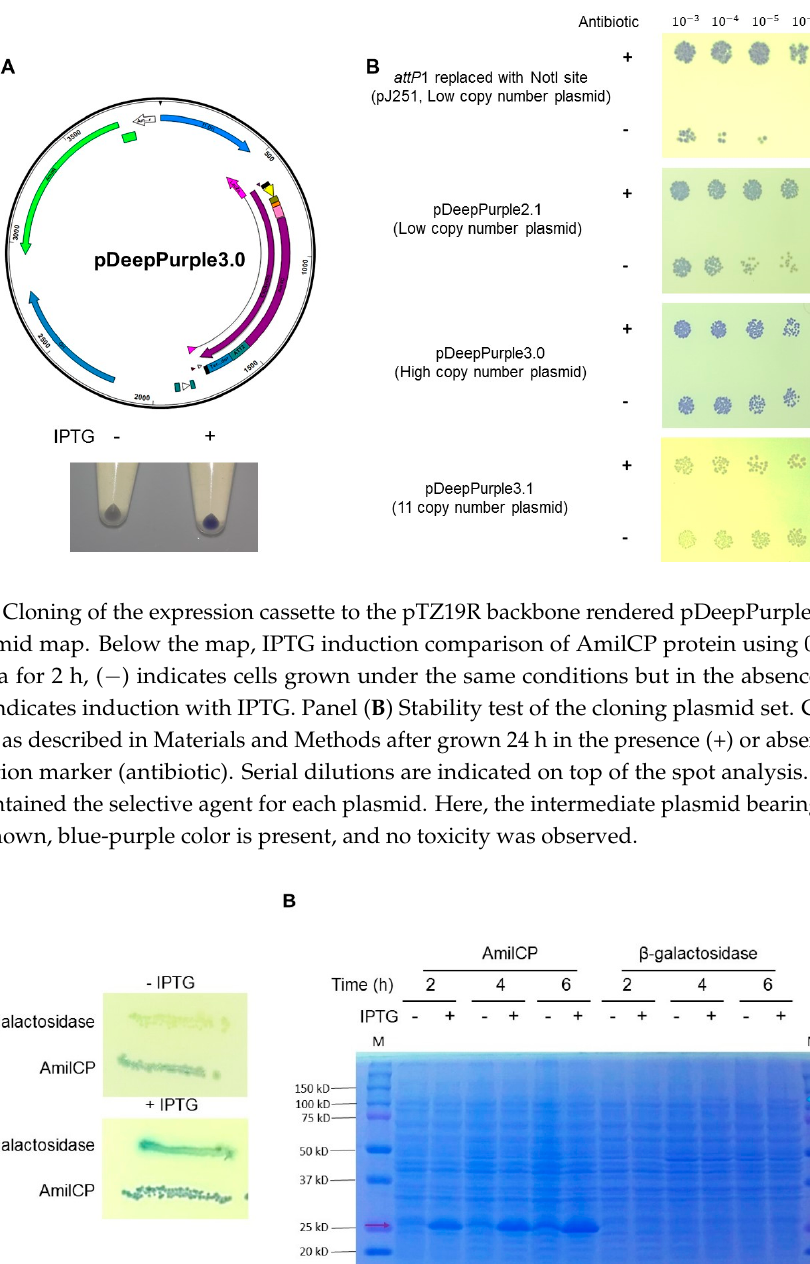
Figure 6. Protein expression is achieved in pDeepPurple3.0 plasmid. Panel ( A ), colony analysis of transformants obtained and the empty vector. One positive colony for β -galactosidase coding sequence was analyzed in the absence ( − ) or presence (+) of IPTG. In both conditions, plates contained X-gal. Panel ( B ), SDS-PAGE/Coomassie-stained gel electrophoresis analysis of the plasmid expressing only AmilCP (pDeepPurple3.0) or the pDeepPurple3.0 expressing the β -galactosidase enzyme. The induction times are indicated. − and + symbols indicate cells uninduced and induced with IPTG respectively. M, Bio-Rad dual color protein size marker.